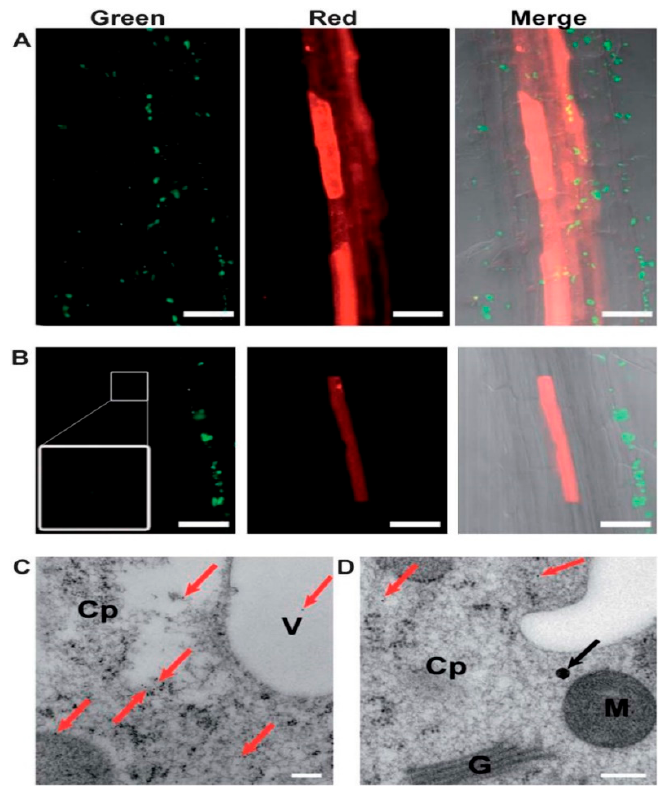
Figure 6. Delivery of genes (MSN-mediated). ( A , B ) Confocal microscopy of Arabidopsis root cells treated with DNA–MSN complexes (1:100 ratio) for 48 h at 24 °C in 1/2 MS. Gene expression (mCherry protein; red) was observed in endodermal ( A ) and cortical ( B ) cells. TMAPS/F-MSNs were present in cells expressing mCherry ( B , green channel). Scale bars: 50 mm. ( C , D ) TEM of immunogold-labelled mCherry protein in root cells after incubation with DNA–MSN complexes. Red arrows show the gold-labeled mCherry proteins. Presence of TMAPS/F-MSNs (black arrow) and mCherry protein (red arrows) in the same cell ( D ). Scale bars are 200 nm. Cp, cytoplasm; M, mitochondrion; V, vacuole; G, Golgi apparatus. Reproduced from Reference [120] with permission from The Royal Society of Chemistry.